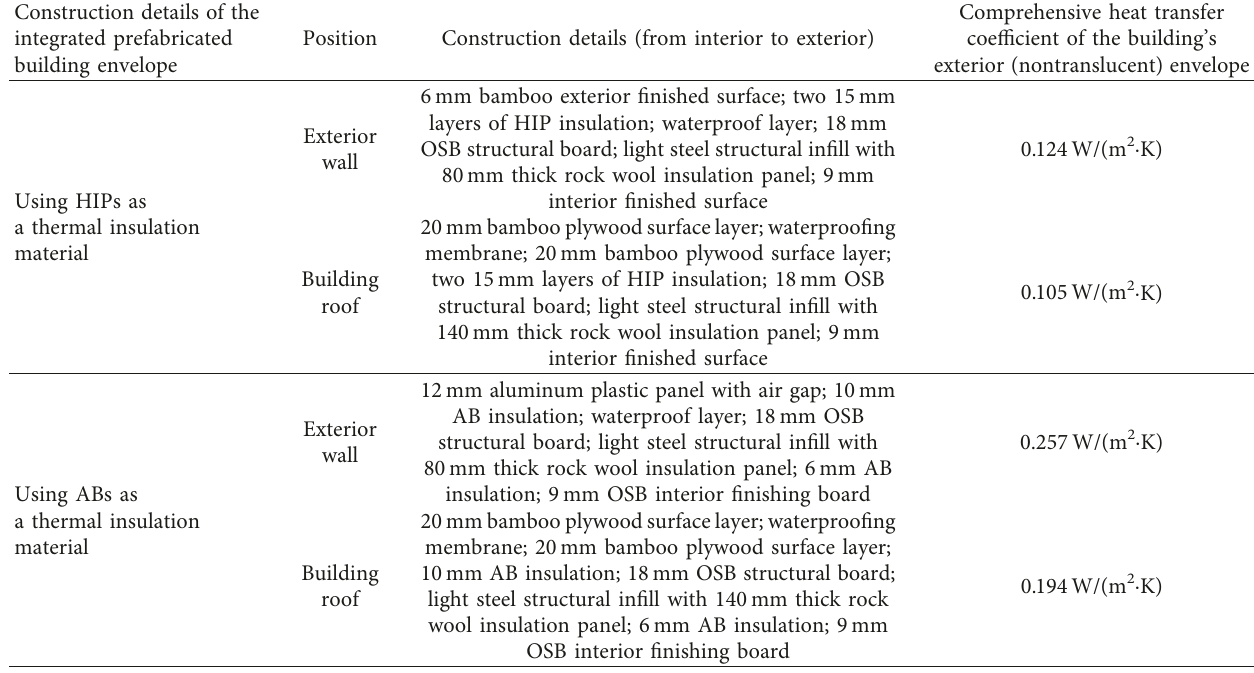
Table 2: Heat transfer performance of the integrated envelope.